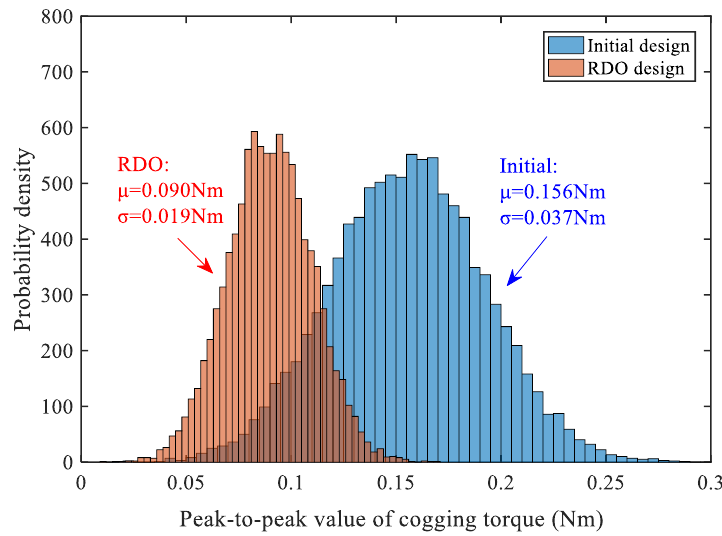
Figure 17. Cogging torque distribution based on Monte Carlo simulation.